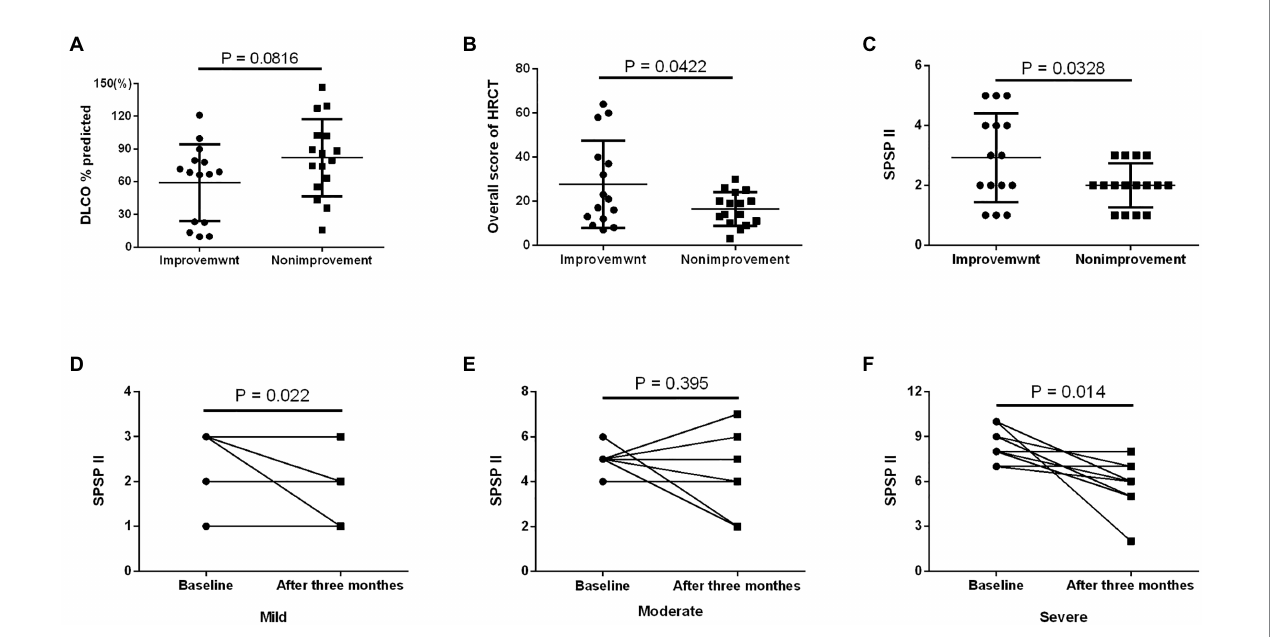
FIGURE 3 Comparison of patients at baseline and after 3 months in the prospective study. Changes in some variables of 31 patients at baseline and after 3 months: (A) % predicted DLCO; (B) overall score of HRCT; (C) SPSPII. Changes in SPSPII of patients at baseline and after 3 months in different severity; (D) mild group; (E) moderate group; (F) severe